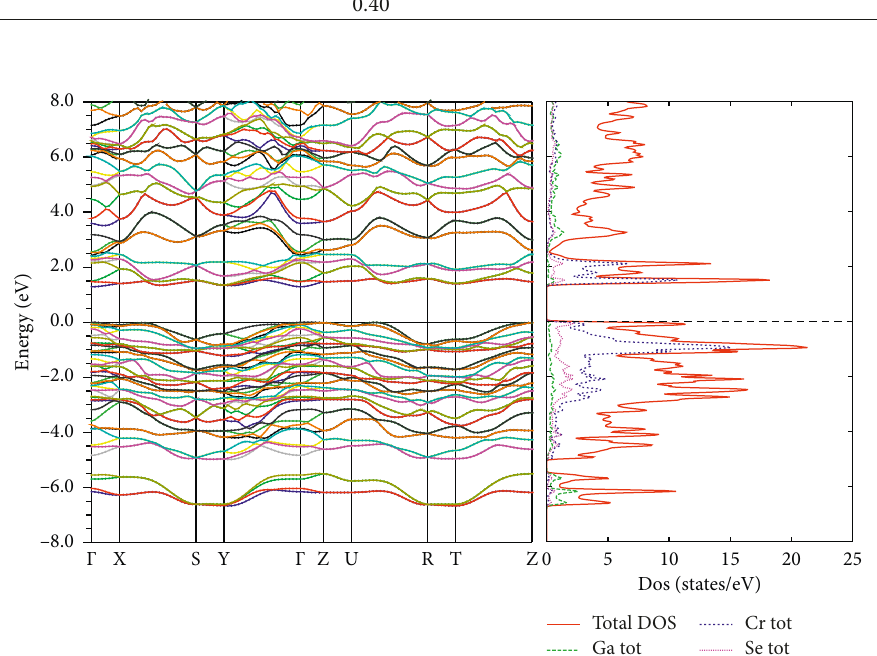
Figure 4: Calculated electronic band structure and density of states for GaCrSe